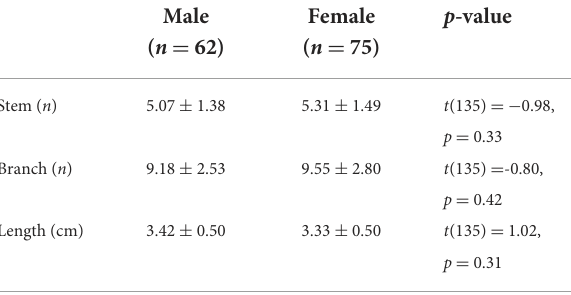
TABLE 2 The characteristics of LSA between men and